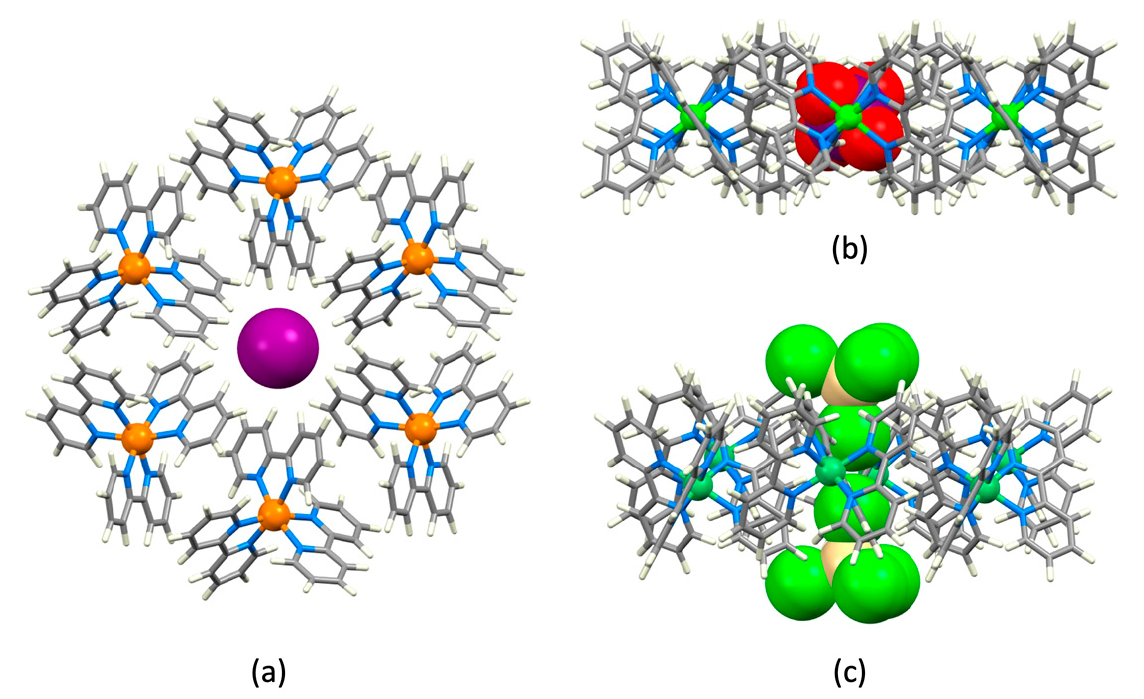
Figure 1. Hexagonal motifs in ( a ) [Li(bpy) 3 ]I·bpy (CSD refcode REXVOF) [19], ( b ) [Zn(bpy) 3 ][CrO 4 ] 0.5 [NO 3 ] . 6.5H 2 O (refcode XUJDEL) [20], and ( c ) [Ni(bpy) 3 ][CdCl 4 ] (refcode BINZON) [21]. Color code: C, gray; H, o ff -white; N, blue; I, purple; Cl, green; O, red.